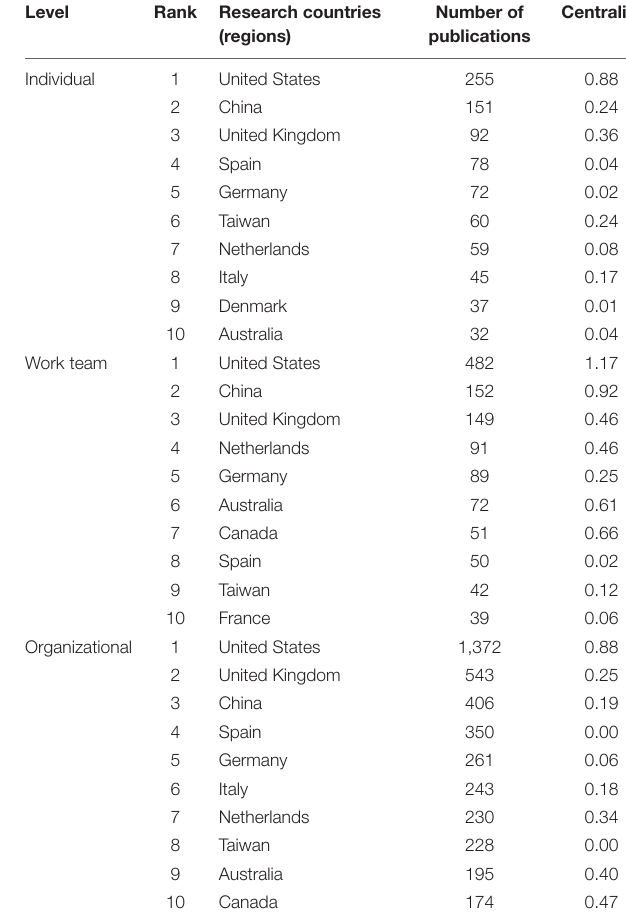
TABLE 1 | Top 10 publication countries (regions) of innovation research at different